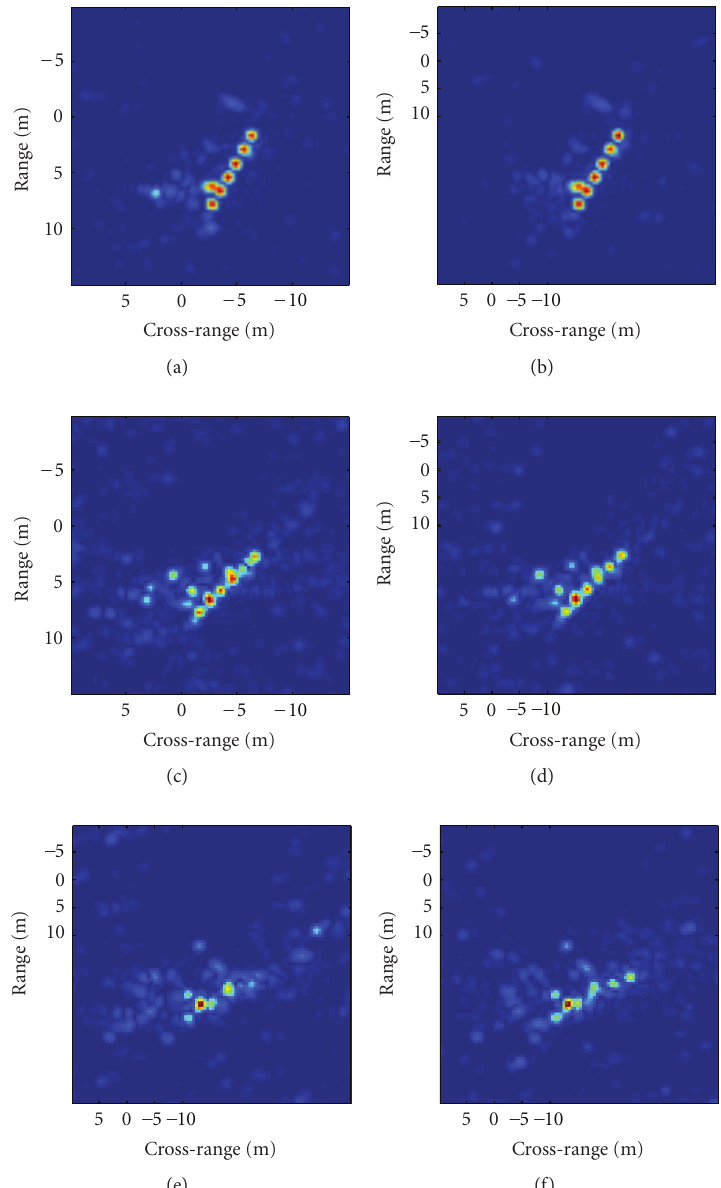
F 6: e 2D HH-polarization SAR images of the tank target above Gaussian rough surfaces with different sizes, in which the incident angle is ( ∘ 𝜃𝜃 𝜃 𝜃𝜃